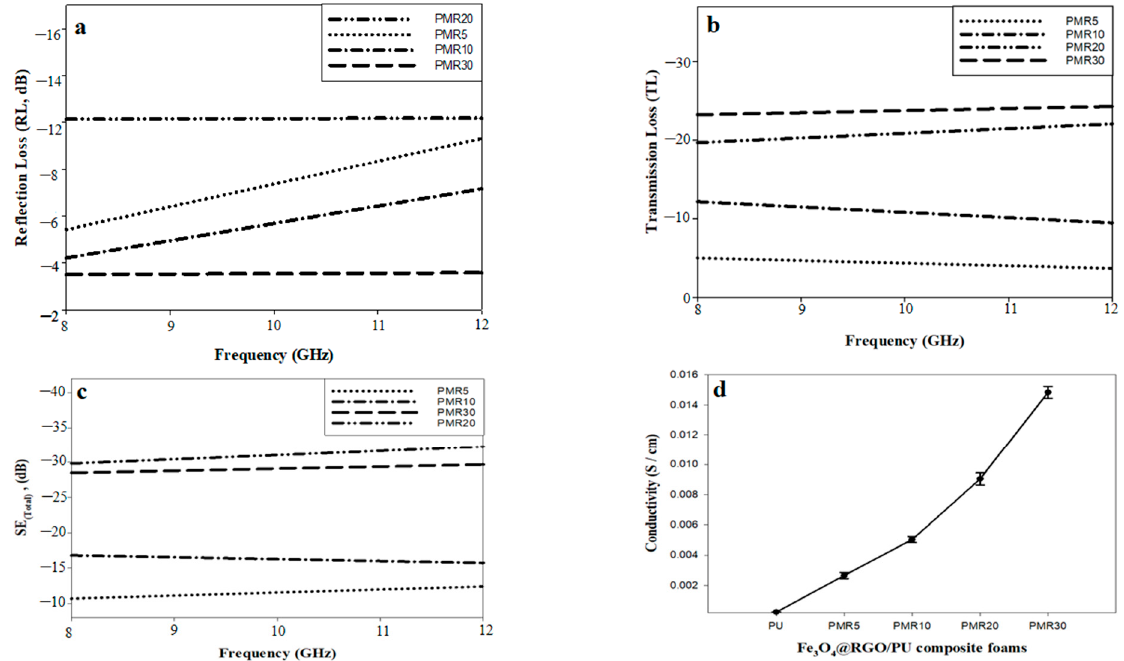
Figure 11. ( a ) Reflection loss. ( b ) Transmission loss. ( c ) Total shielding as a function of the frequency for PMR5, PMR10, PMR20, and PMR30. ( d ) The electrical conductivity results for the PU composite foams.